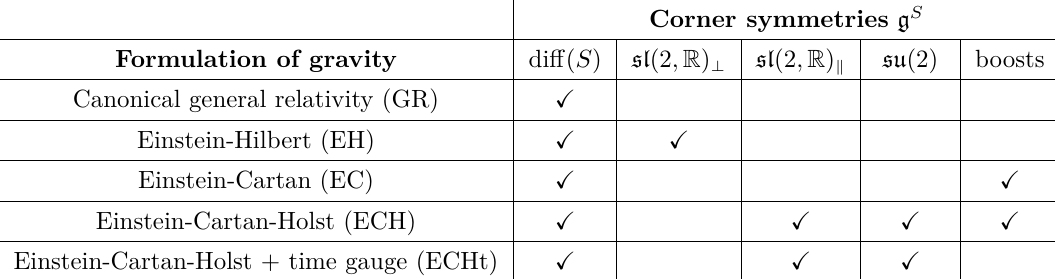
Table 1. Checkmarks denote which sectors of the corner symmetry algebra present a non-trivial representation in the given formulation of gravity. The symbols ⊥ and k denote the fact that the corresponding sl (2 , R ) algebra is associated respectively to the normal and tangent parts of the metric at the corner. su (2) and boost denote the decomposition of the corner Lorentz symmetry algebra. For instance su (2) is trivially represented in Einstein-Cartan and non-trivially represented in Einstein-Cartan with the Holst